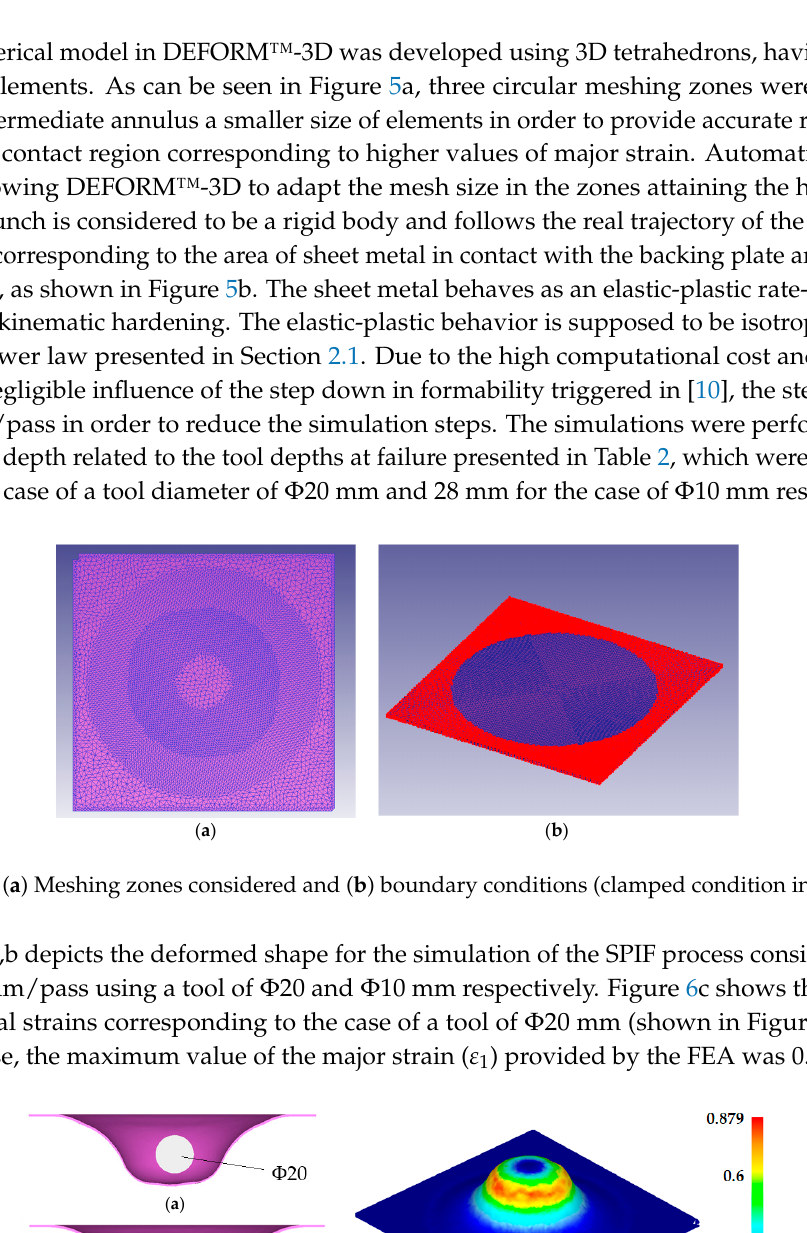
Figure 6. ( a ) Deformed shape provided by DEFORM™-3D of the final testing part in SPIF using a tool of Ф 20 diameter and ( b ) Ф 10 mm. ( c ) contour of principal strain for the case of Ф 20 mm.